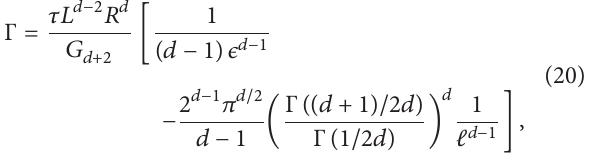
Figure 1: ℓ as a function of 𝑟 𝑡 for the cases of 𝑄 = 0, 0.3, 0.5 which are shown by red, green, and, blue, respectively. The blue curve corresponds to the case of 𝑟 𝐻 = 𝑟 𝜙 , while the red one represents the neutral black